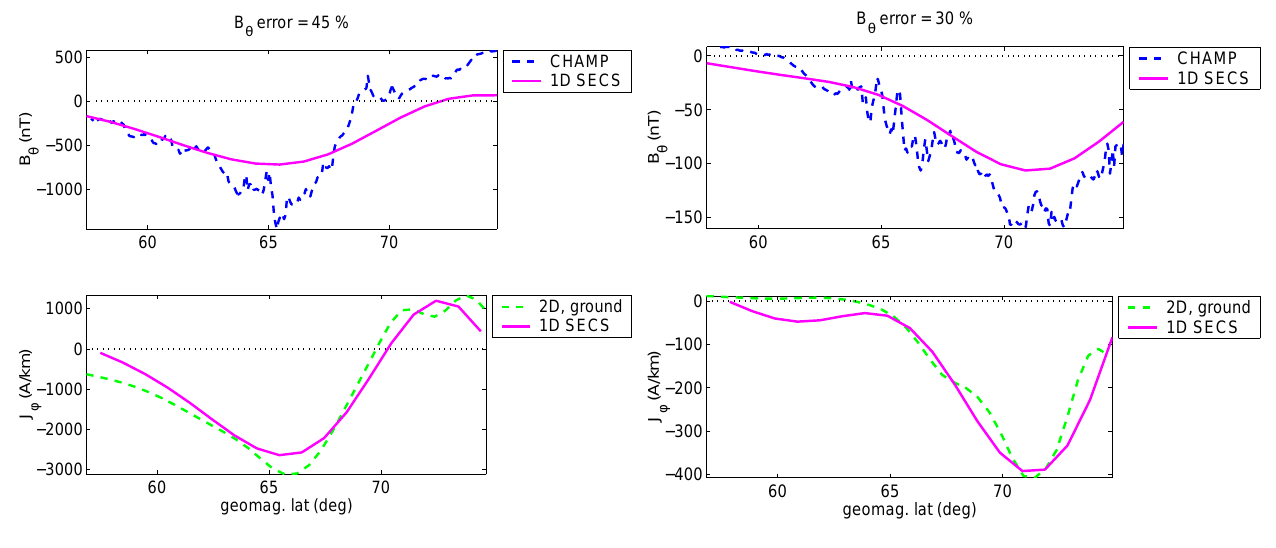
Fig. 4. Left: Top: B θ measured by CHAMP on 6 November 2001 at 05:04–05:08 UT above IMAGE, and the 1D SECS B θ attained by fitting B r . The similar shapes of the two curves (error 45%) imply that the current distribution is reasonably 1D during the overflight. Bottom: J φ determined from CHAMP data by the 1D SECS method and from IMAGE data by the 2D SECS method. As expected in a 1D case, the two profiles are almost the same. Right: The same as on the left hand side, but on 20 November 2001 at 03:59–04:04 UT.